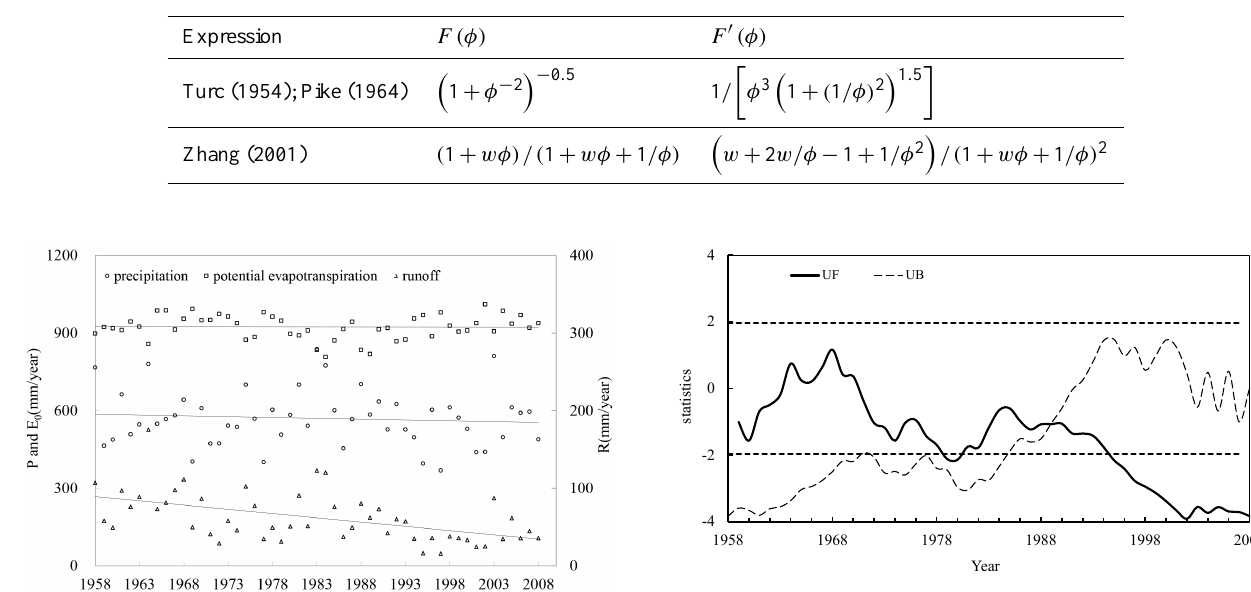
Figure 4 Flow duration curves under different periods in the Wei river basin 596